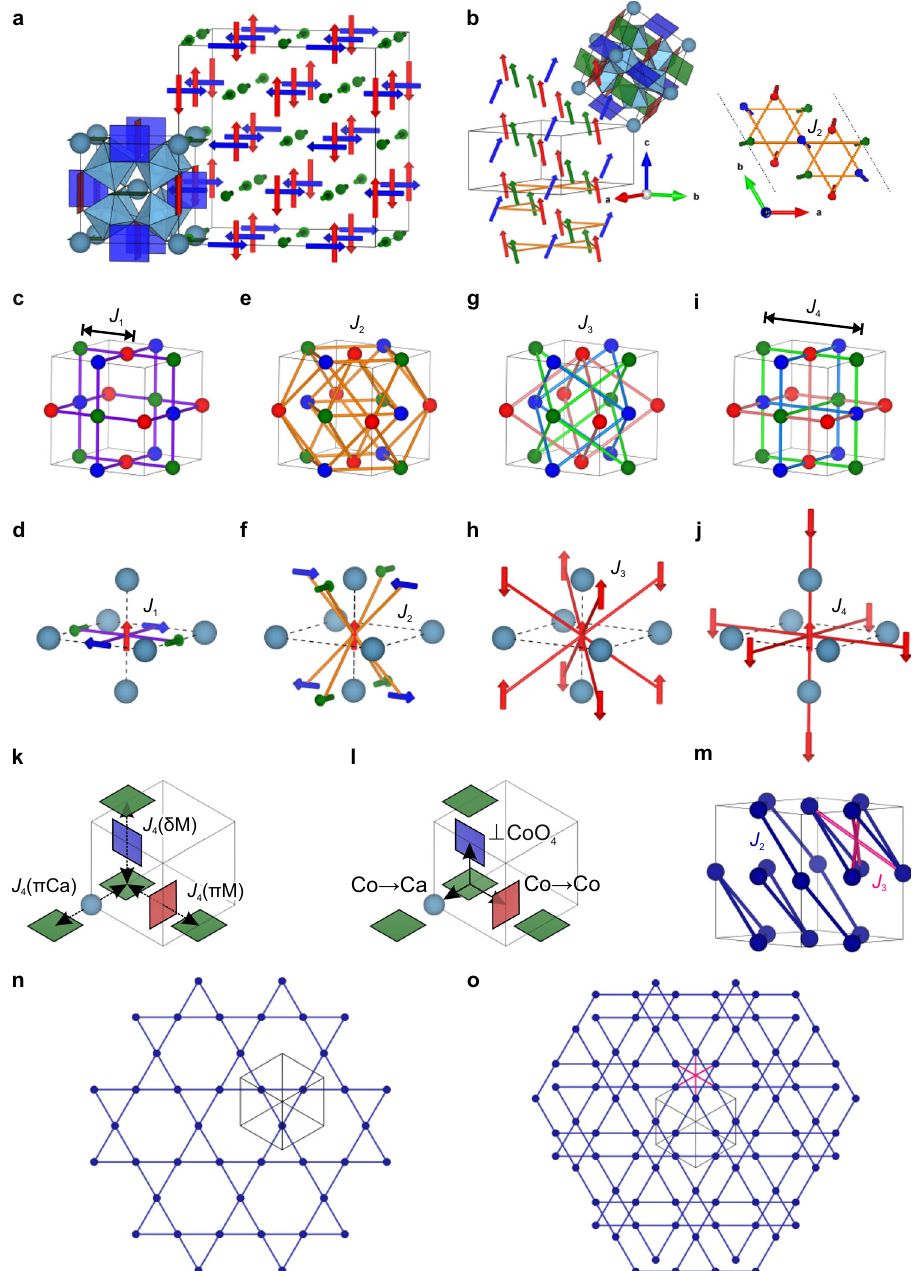
Fig. 2 Magnetic structures of CaCo 3 Ti 4 O 12 and spin interactions in quadruple perovskites. Re fi ned magnetic structures of CaCo 3 Ti 4 O 12 at 1.6 K and under a 0 T and b 8 T. Red, blue, and green centres each correspond to a set of CoO 4 square planes sharing a common orientation. c J 1 exchange between 1NN. d Relative arrangement of 1NN centres in the 0 T magnetic structure of CaCo 3 Ti 4 O 12 . e J 2 exchange between 2NN. f Relative arrangement of 2NN centres. g J 3 exchange between 3NN. h Relative arrangement of 3NN centres. i J 4 exchange between 4NN. j Relative arrangement of 4NN centres. k Three different J 4 interactions. l Moment directions considered during DFT calculations (detailed in the Supplementary Fig. 4). m Arrangement of the kagome layers along the [111] direction. n A kagome layer of J 2 spins perpendicular to [111]. o Projection view of two adjacent kagome layers of J 2 spins perpendicular to